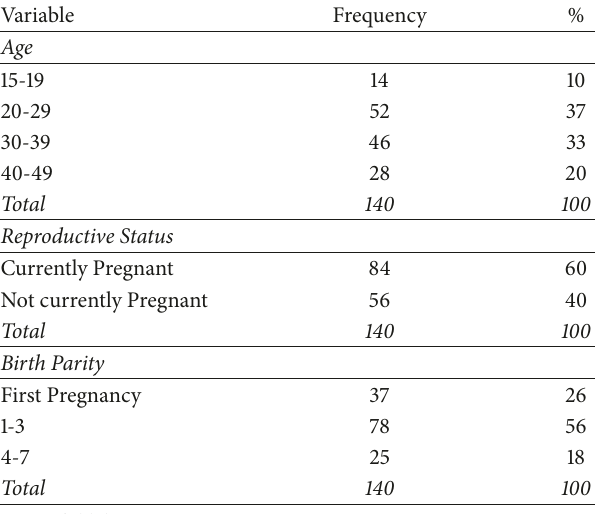
Table 2: Demographic features of WIFA